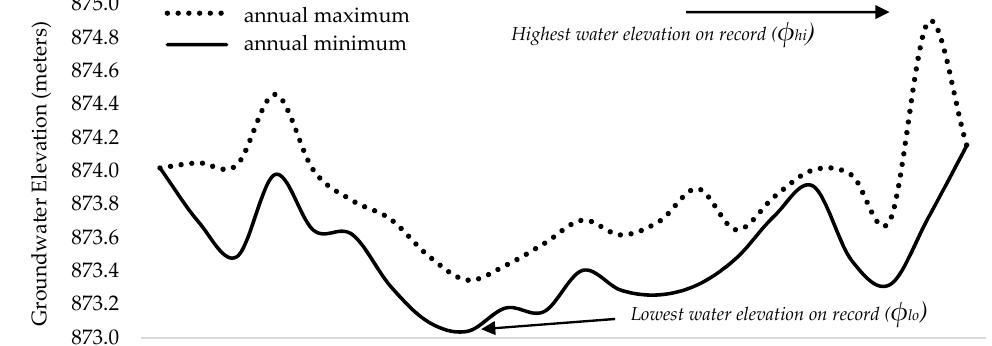
Figure 4. Maximum and minimum static groundwater level elevations ( φ ) measured between 1994 and 2015 from GWAAMON well 147334 [90,91]. The peaks evident in 1997 and 2014 reflect major flooding during those years. Low 2002 values reflect a statewide drought that led to Montana’s designation as a disaster area [92].